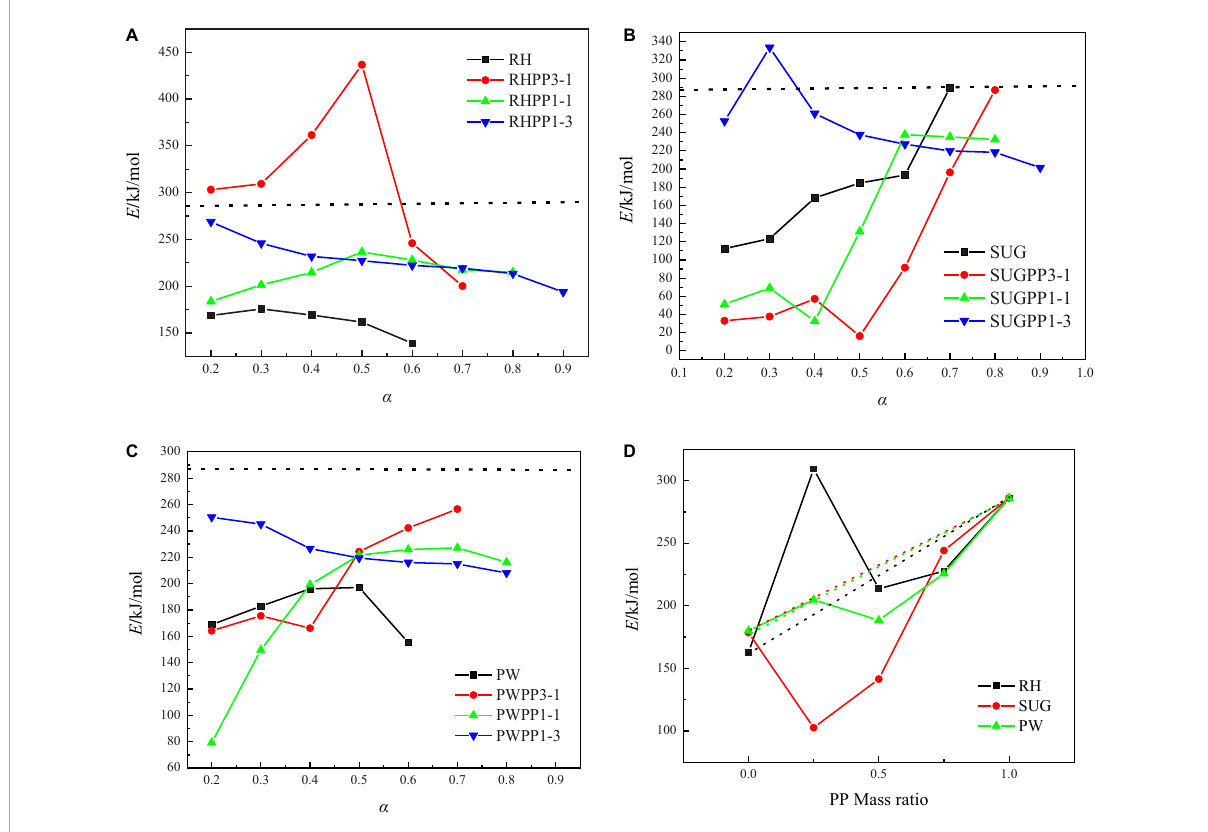
FIGURE6 Variation profiles of E under various α for biomass with PP on Starink method, (A) RH and PP mixtures, (B) SUG and PP mixtures, (C) PW and PP mixtures, (D) average values of E versus biomass mass ratio (dotted lines were the predicted value of the average E based on the weighted average of the PP and